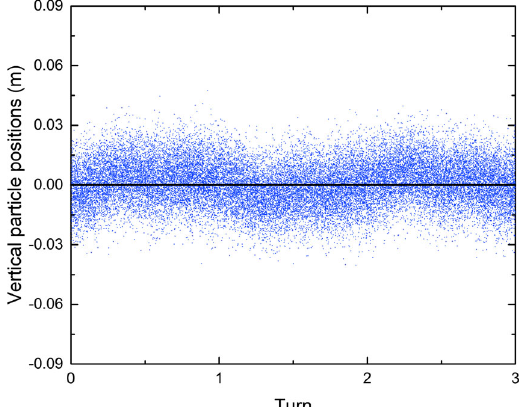
FIG. 11. Coasting beam is oscillating around the central orbit in the 400 MeV = u Kr 19 þ beam simulation with the transverse impedance and the space